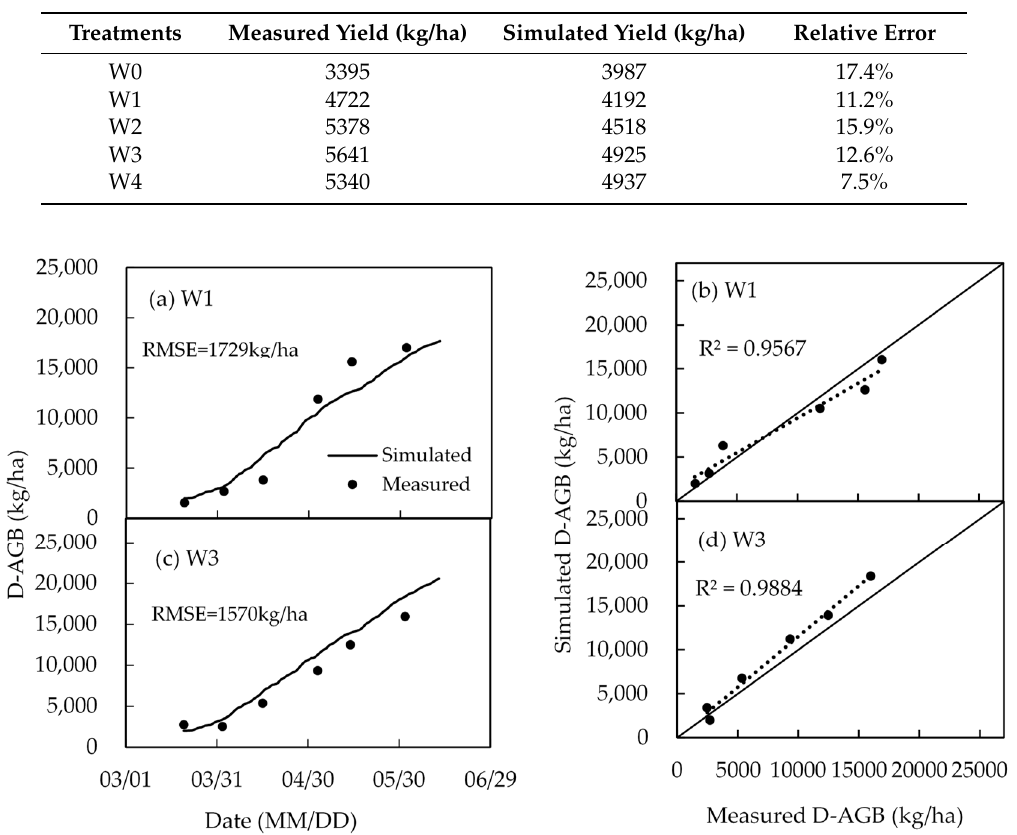
Table 4. Comparison between simulated and measured yield under different water treatments.